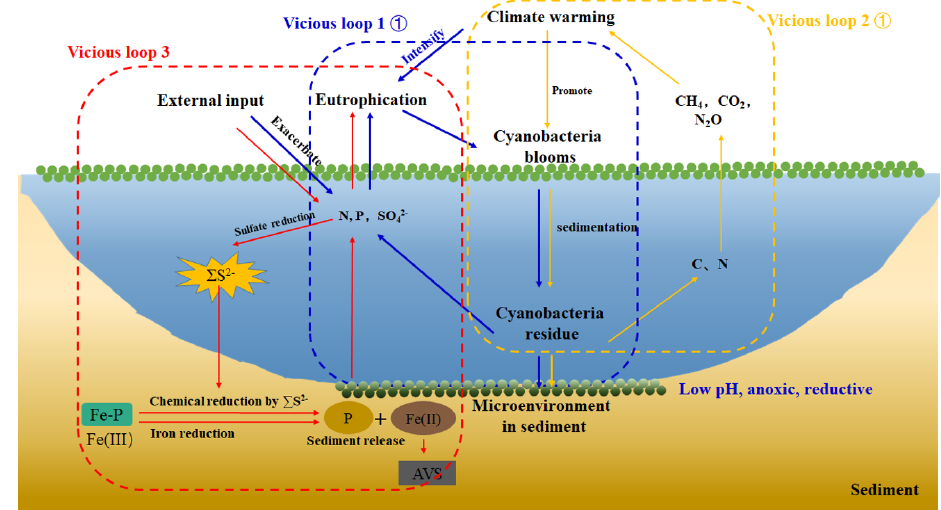
Figure 6. A simplified scheme of the relationship among climate warming, lake eutrophication, and cyanobacteria blooms in eutrophic lakes. Under climate warming scenarios, extreme abiotic and biotic conditions facilitated the breakout of cyanobacteria blooms. After their collapse, the high amount of N, P, and C were released into the overlying water and reacted with the eutrophication. Furthermore, a large amount of CH 4 and CO 2 was produced and emitted to the atmosphere, contributing to global warming from freshwater lakes (Yan et al., 2017). With the external sulfur input, the concentration of SO 2 − increased significantly, and sulfate reduction was enhanced. The cyanobacteria 4 decomposition created an anaerobic reduction environment, which will promote iron reduction and sulfate reduction. The free Fe 3 + generated by Fe-P desorption was reduced to Fe 2 + and combined with (cid:80) S 2 − , which through sulfate reduction formed stable Fe-S in the sediments. Phosphorus was released from the sediment into the overlying water. Therefore, there are three vicious loops between cyanobacteria bloom occurrence, lake eutrophication, and climate